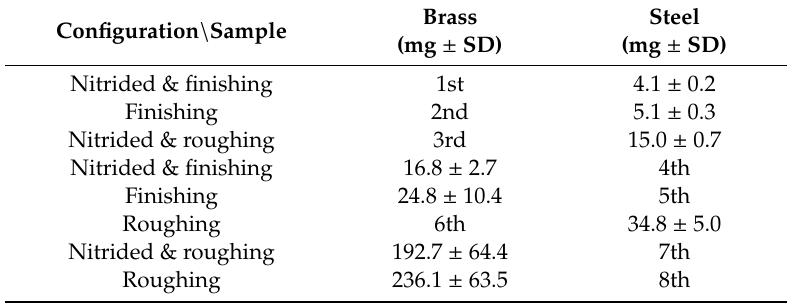
Table 3. Average weight loss and its standard deviation in increasing order to identify which surface conditions and treatments present lower wear.